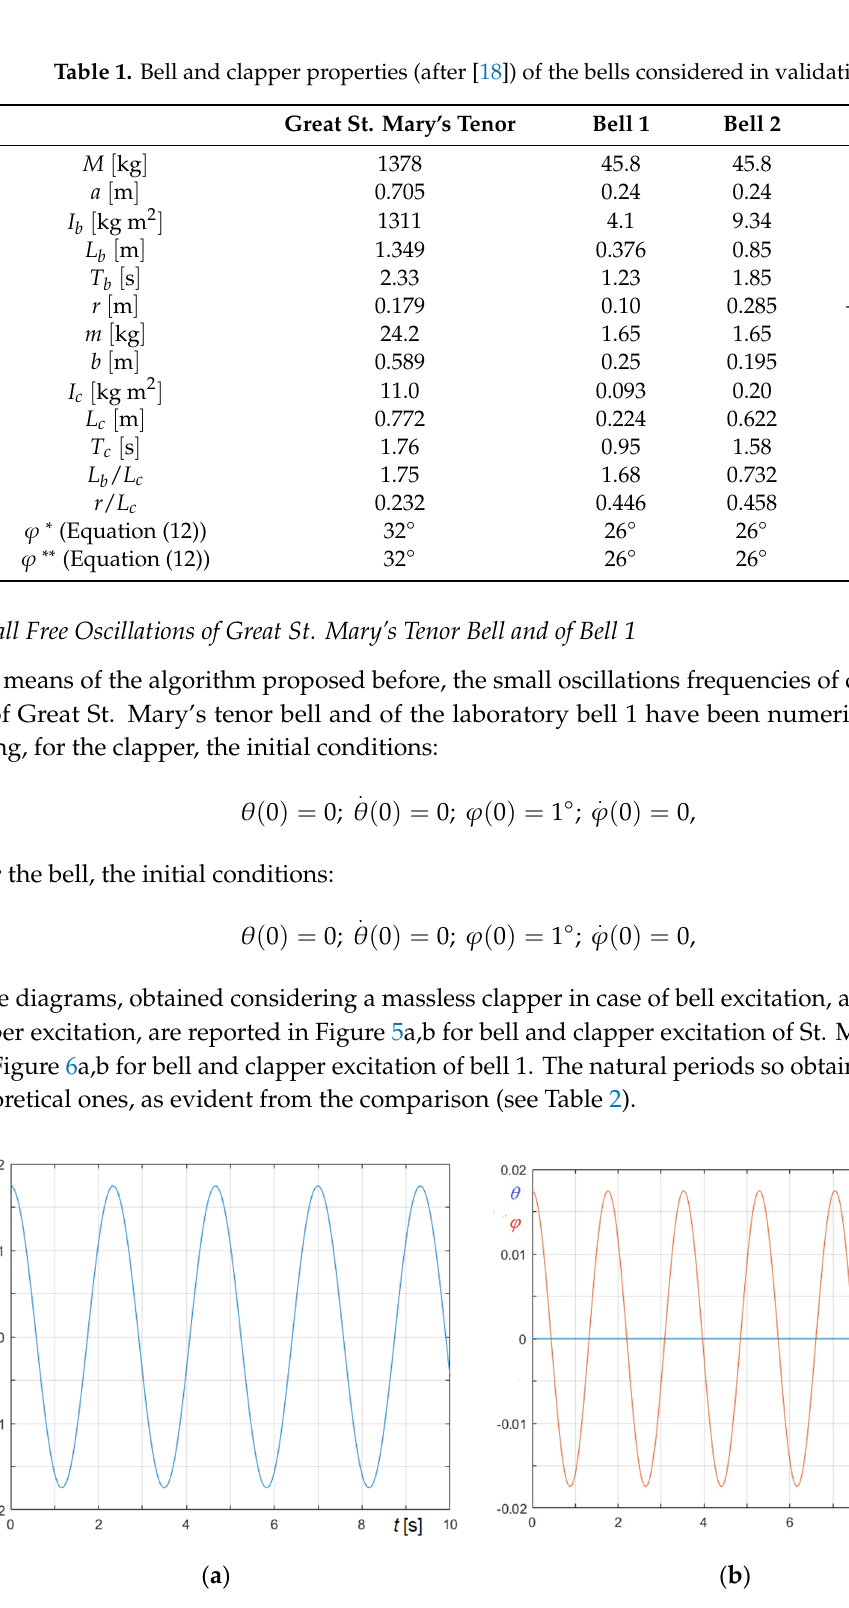
Figure 5. Small free oscillations of the St. Mary’s tenor bell: ( a ) Oscillation of bell in case of bell excitation; ( b ) Oscillation of bell and clapper in case of clapper excitation.